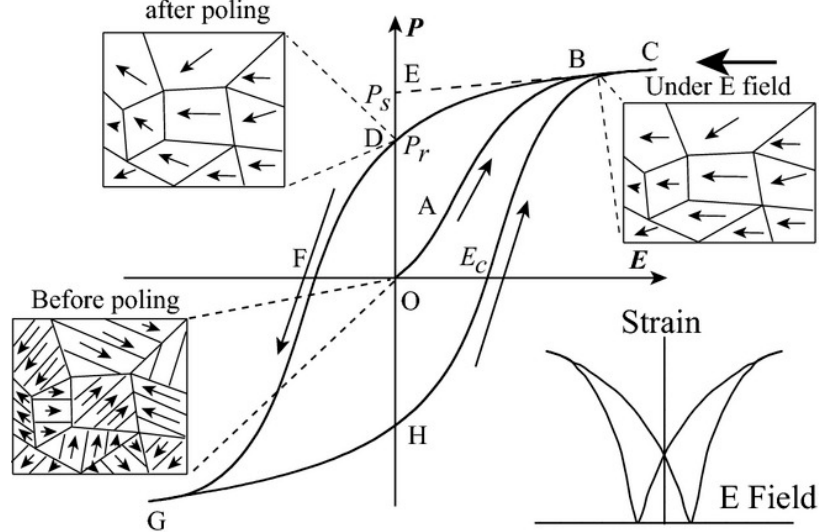
Figure 7. A typical hysteresis loop in ferroelectrics and strain-electric field curve. Reprinted with permission from [24]. Copyright 2013 The American Ceramic Society.